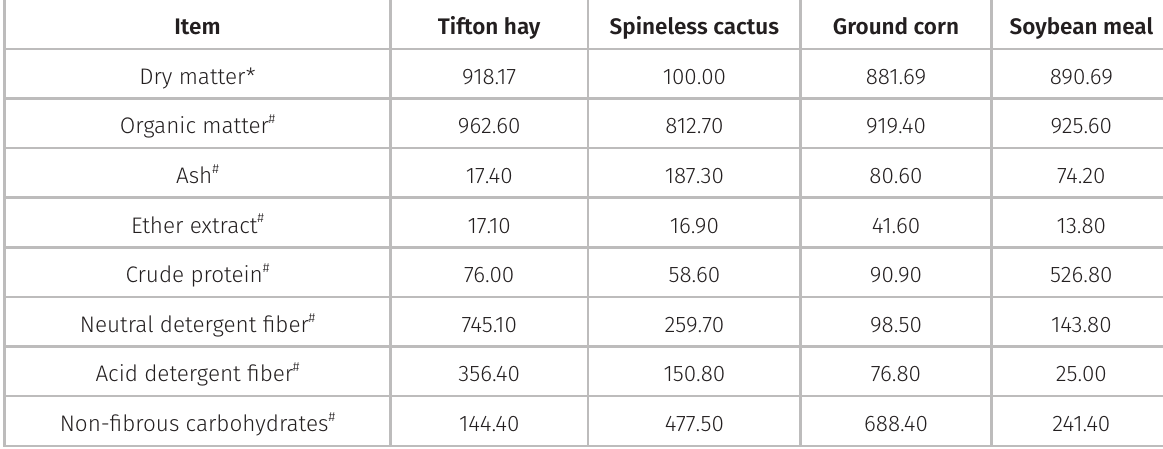
Table I. Chemical composition of the diets